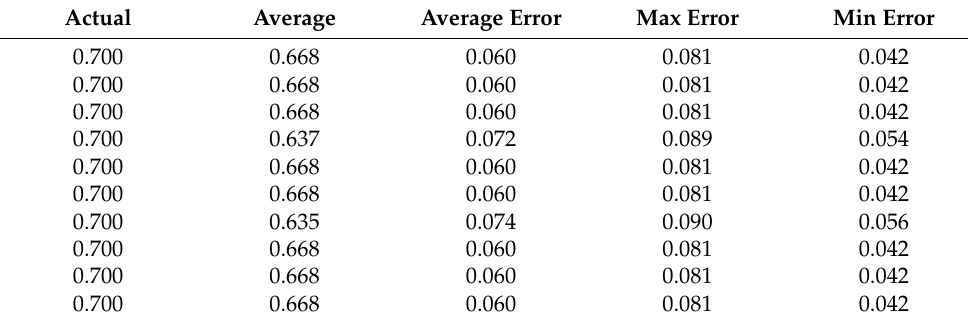
Table A127. Set 2, trials 31–40 data (all 0.5 PR values).